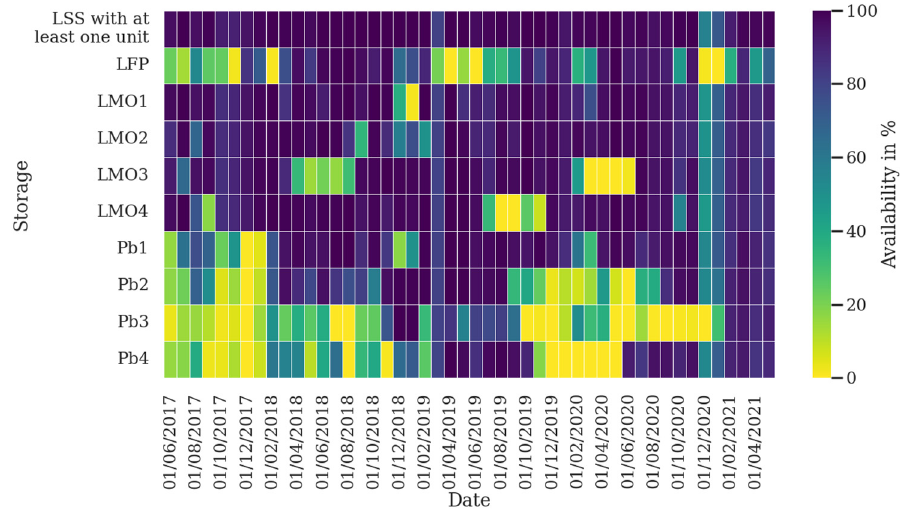
Figure 4. Monthly mean availability of battery units and LSS.